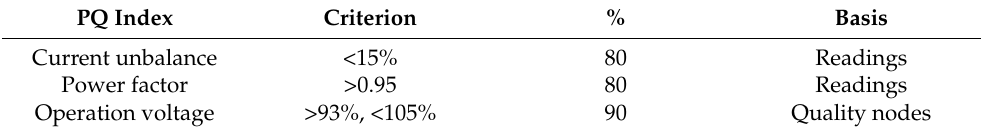
Table 1. PQ Indices Criteria. PQ Index Criterion % Basis Current unbalance <15% 80 Readings Power factor >0.95 80 Readings Operation voltage >93%, <105% 90 Quality